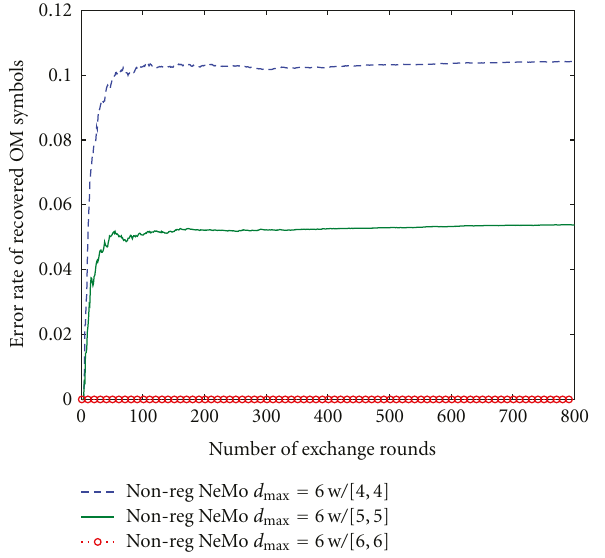
Figure 8: E ff ect of finite-bit storage on NeMo.